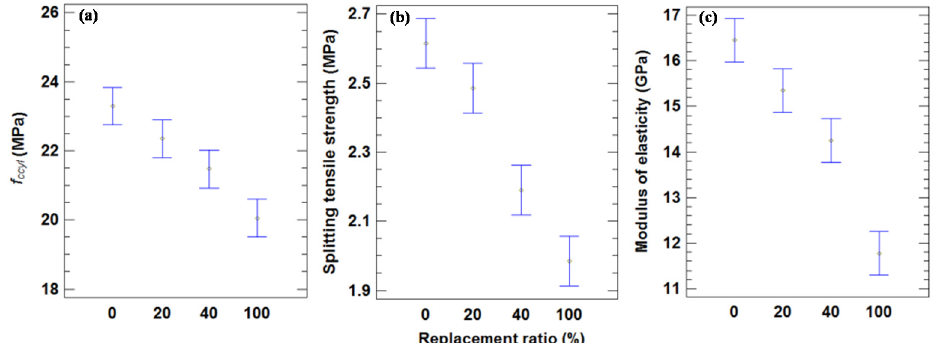
Figure 7. ( a ) Mean values of compressive strength in cylindrical specimens and 95% LSD intervals vs. replacement ratio. ( b ) Mean values of splitting tensile strength in cylindrical specimens and 95% LSD intervals vs. replacement ratio. ( c ) Mean values of modulus of elasticity and 95% LSD intervals vs. replacement ratio.